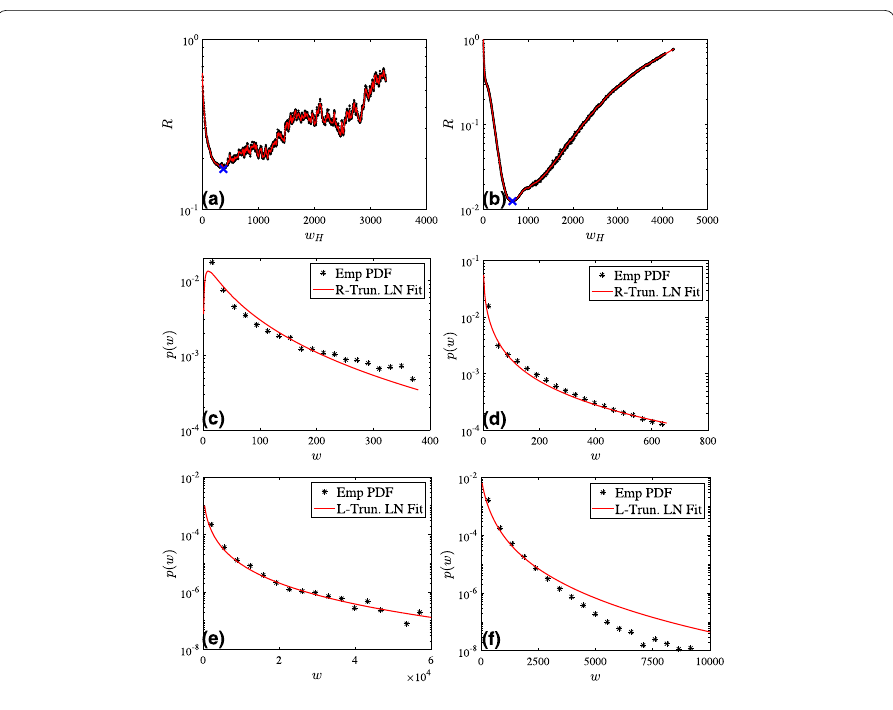
Figure 3 Results of the optimal truncated distribution of weighted degrees for SVEIN ( a ), ( c ), ( e ) and SVCN ( b ), ( d ), ( f ). ( a ), ( b ) Plots of the fitting residual (Eq. (7)) as a function of threshold k H . ( c ), ( d ) Plots of the right-truncated degree distributions. ( e ), ( f ) Plots of the left-truncated degree